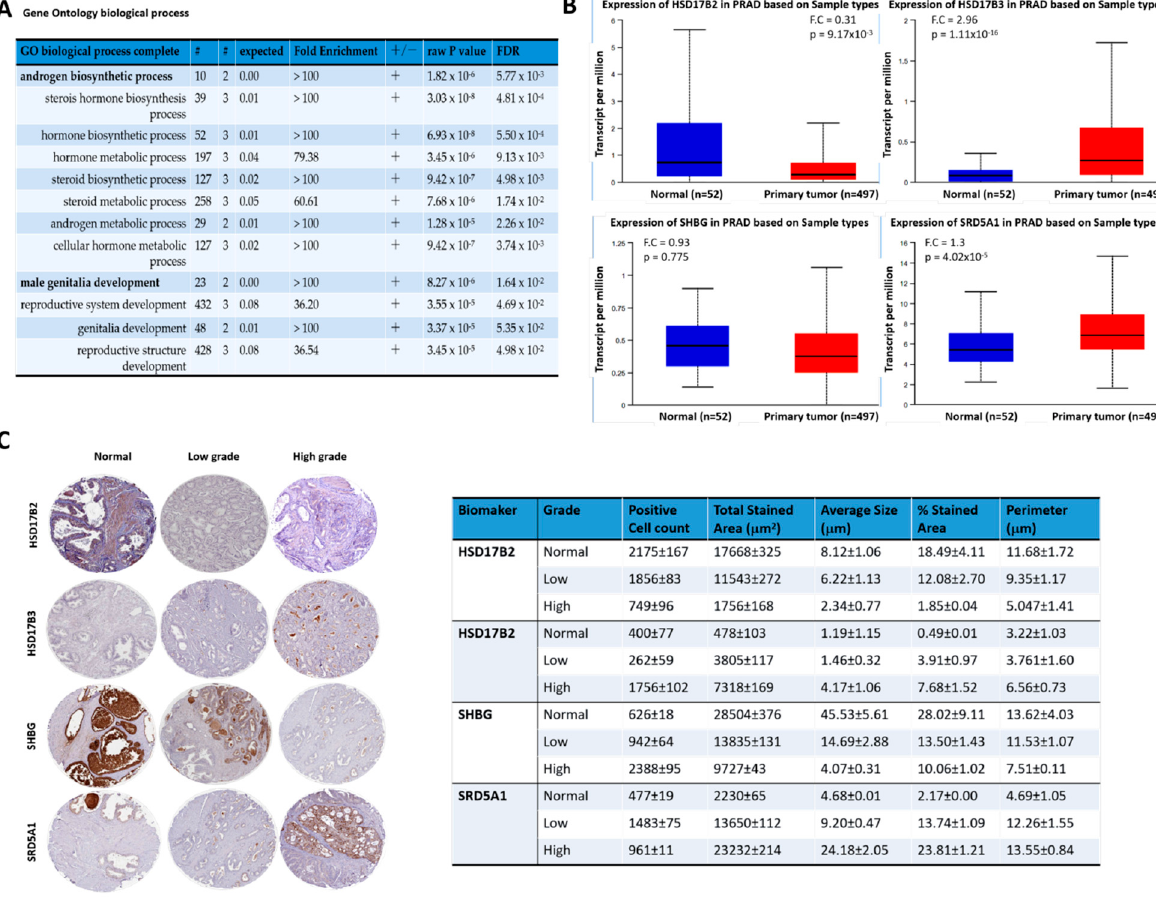
Figure 1. The aberrant expression of the testosterone metabolic tetrad HSD17B2, HSD17B3, SHBG, and SRD5A1 charac ‐ terize androgen ‐ addicted PCa and is associated with disease progression. ( A ) Depiction of the gene ontology biological ‐ process ‐ based Fisher’s exact overrepresentation test using the GO Ontology database. ( B ) Histograms showing the differ ‐ ential expression of HSD17B2, HSD17B3, SHBG, or SRD5A1 mRNA in normal and primary tumor from the TCGA PRAD cohort. ( C ) Representative photo ‐ images and quantitative chart of the expression of HSD17B2, HSD17B3, SHBG, or SRD5A1 protein in normal prostate, low ‐ grade, or high ‐ grade samples from the SHH PCa cohort. ( D ) Box and whisker plots showing the differential expression of SRD5A1, SHBG, HSD17B2, or HSD17B3 mRNA according to the AJCC tumor stage. FDR, false discovery rate; F.C, fold change; SHH, Shuang Ho Hospital; AJCC, American Joint Committee on Cancer.